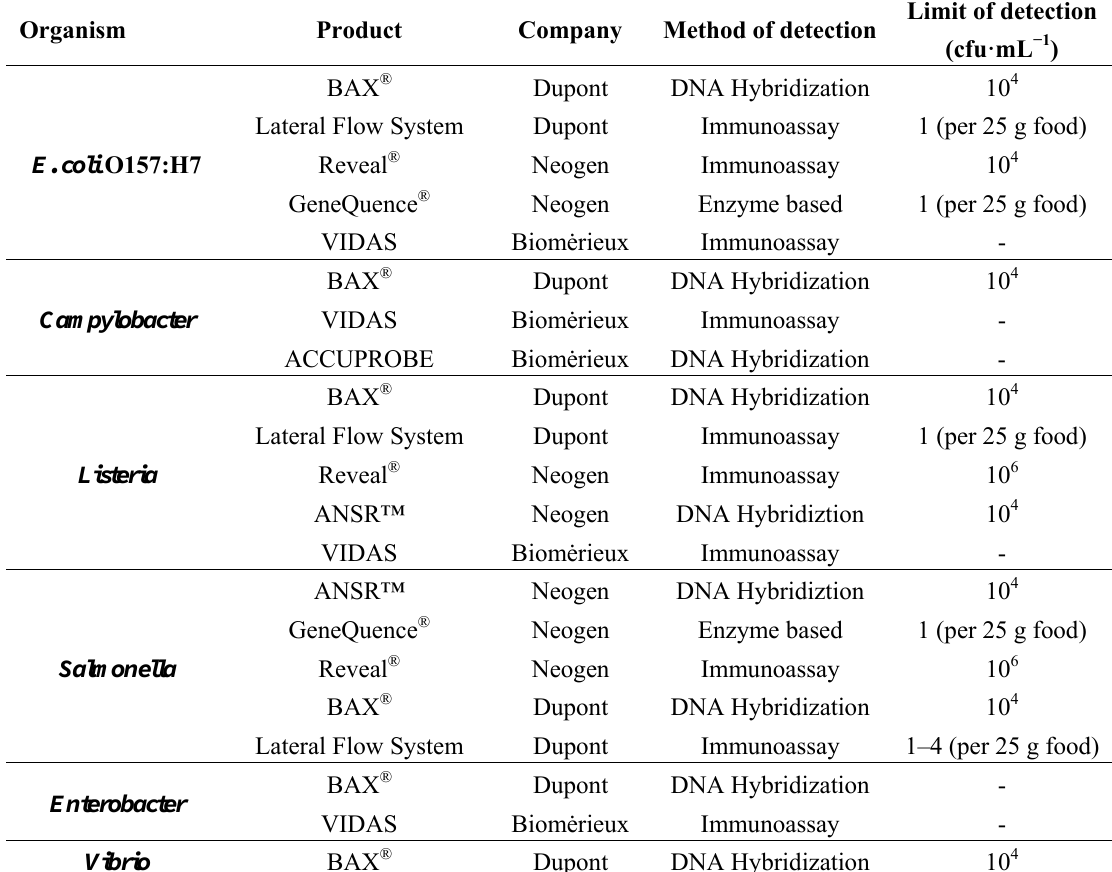
Table 2. A list of nucleic acid and protein-based commercial products for foodborne pathogen detection with their method and limit of